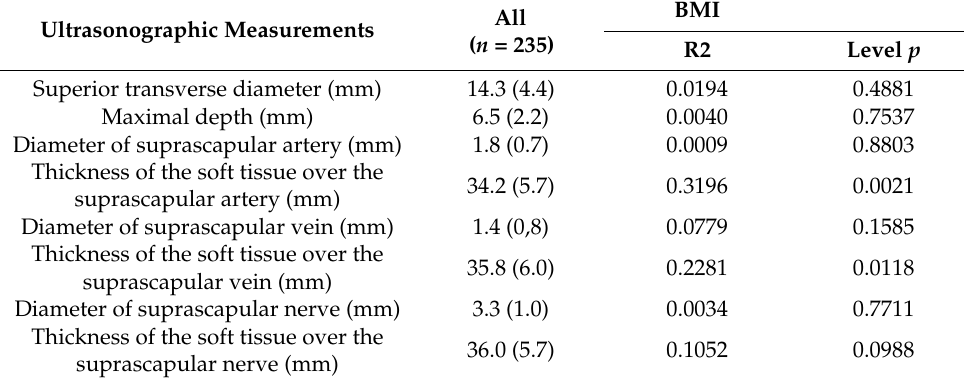
Table 3. Distribution of the sonographic measurement in the whole group, according to BMI. Differences that are significant according to Bonferroni correction are bolded.